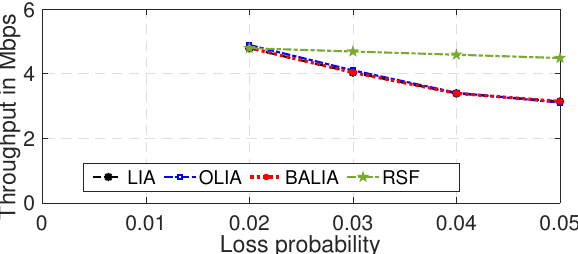
Figure 7. Throughput results for a 10 MB file transfer in Scenario 6: heterogeneous loss paths. One path had 3% packet loss while the loss probability of the other one was varied. Both paths had 20 Mbps bandwidth and 150 ms delay.